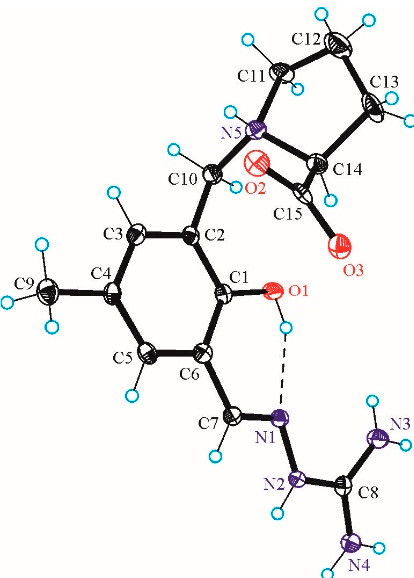
Figure 1. ORTEP view of Pro-SISC-Me·HBr ( 1 ) with thermal ellipsoids at 50% probability level. The counter ions and solvent molecules are omitted for clarity. Selected bond distances (Å) and torsion angles (deg): C1–O1 1.359(5), N1–N2 1.371(5), N2–C8 1.338(6), C8–N3 1.325(6), C8–N4 1.335(6); C1–